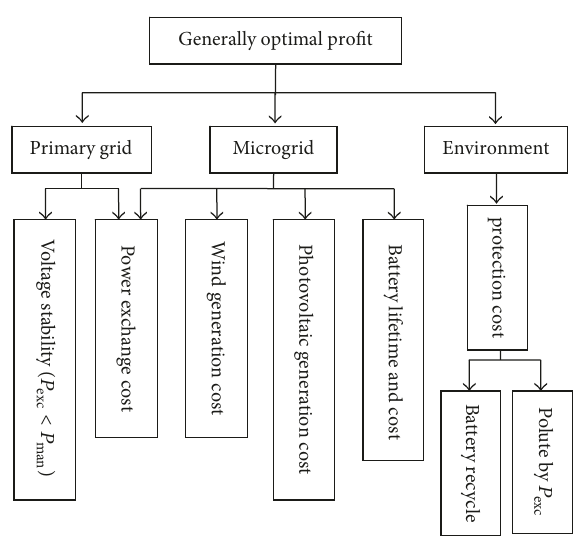
Figure 2: Layer structure